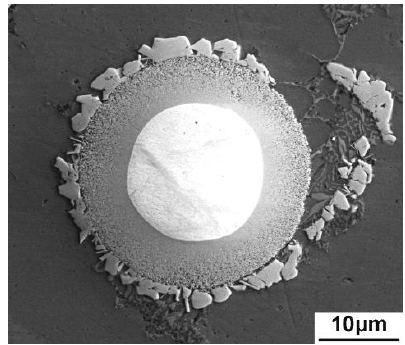
Figure 9. Morphology of a reinforcement in the composite formed at mold temperature of 400 ◦